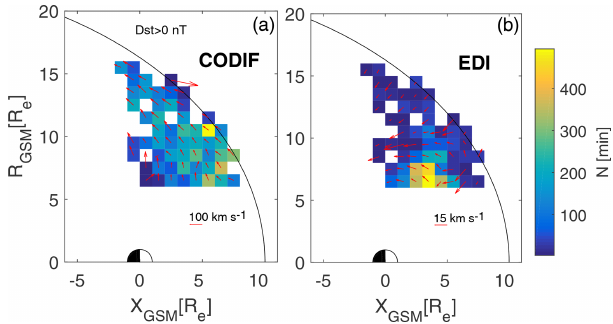
Figure A1. Distribution of average parallel and convection veloci- ties in the cusps and plasma mantle regions for quiet geomagnetic conditions. Lengths of vectors represent convection velocity in each bin, calculated as the average magnitude of vectors. Colors indicate the number of 1min measurements in each bin. Panel (a) depicts parallel velocities obtained using CODIF data; panel (b) depicts convection velocities obtained using EDI data. Vectors are scaled as given in the lower right corner of each panel.